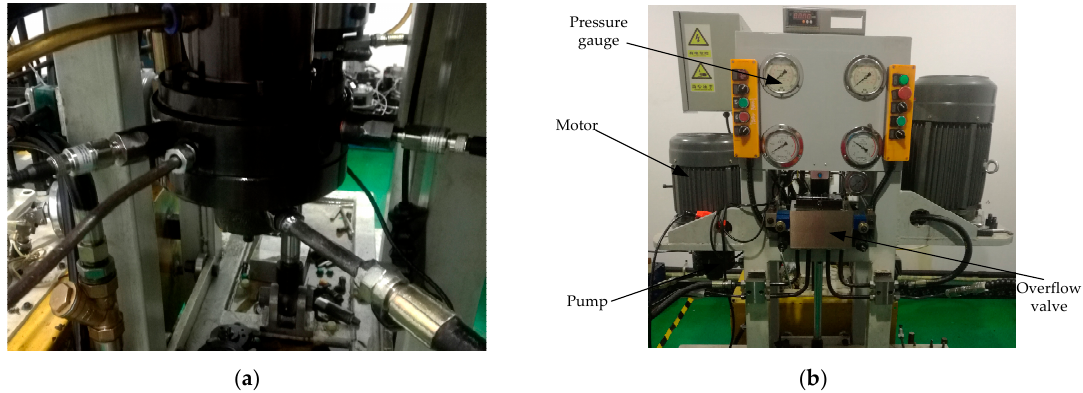
Figure 13. The figure above shows the experimental object: ( a ) Physical drawing of pump; ( b ) physical drawing of pump test bed.